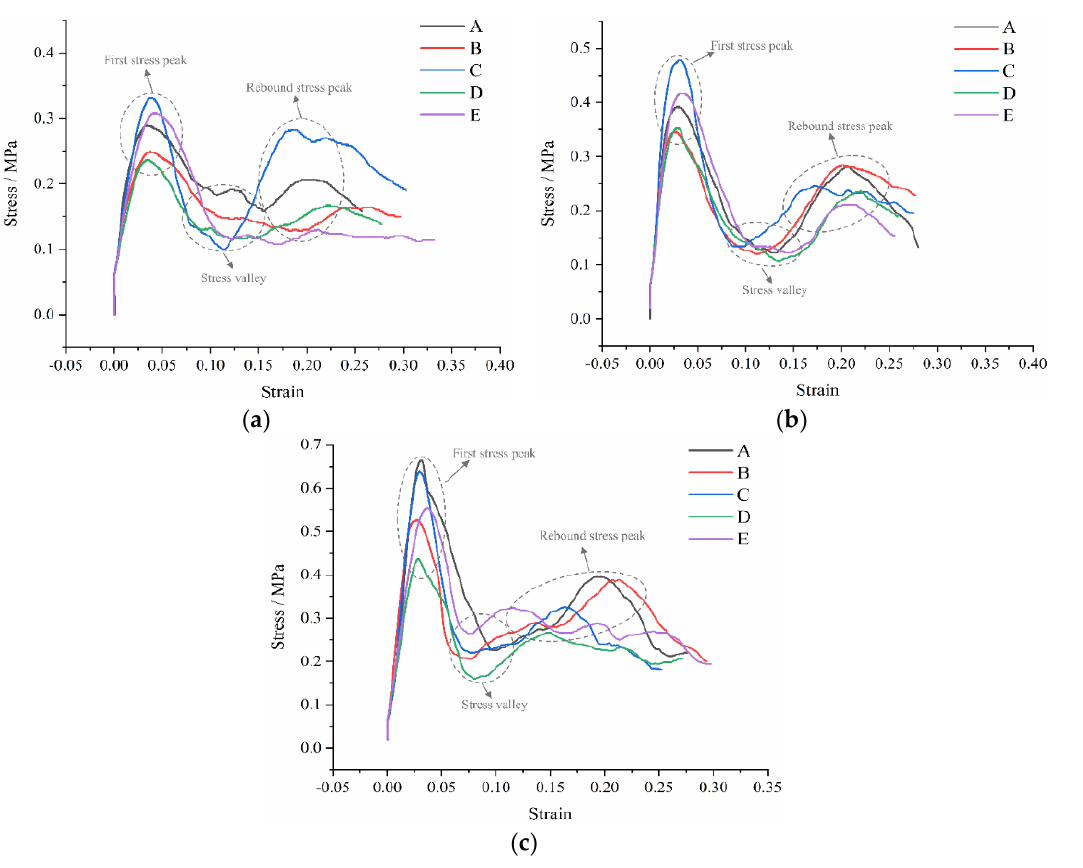
Figure 3. Stress − strain curves of cemented specimens at different curing ages: ( a ) 1 d, ( b ) 3 d, and ( c ) 7 d.